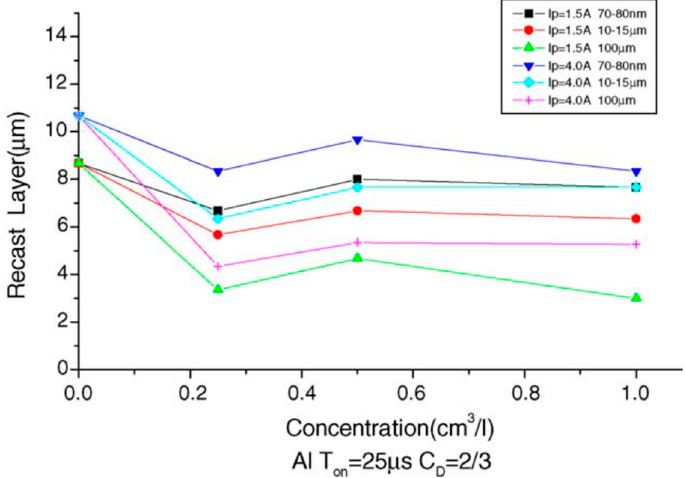
Figure 10. The change in the recast layer thickness with the change in aluminum powder particle size and powder concentration [55]. (With kind permission from Elsevier).